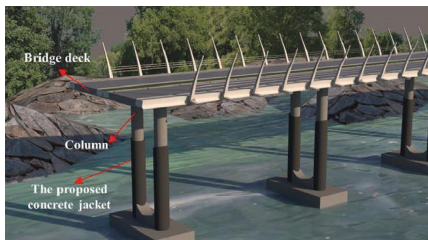
Figure 2: A schematic picture of the place where the concrete jacket is used for bridge columns. Column